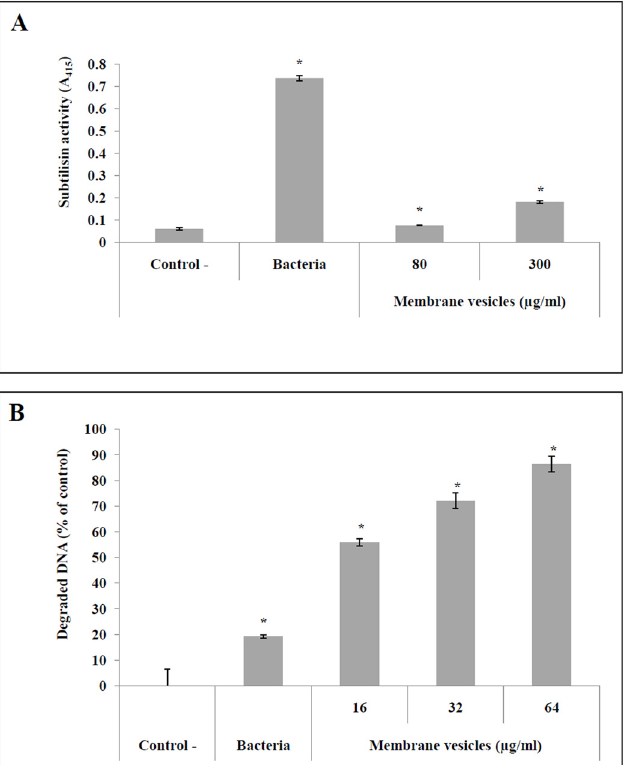
Fig 3. Determination of subtilisin (A) and DNase (B) activities in S. suis membrane vesicles. * : p < 0.05 compared to negative controls.